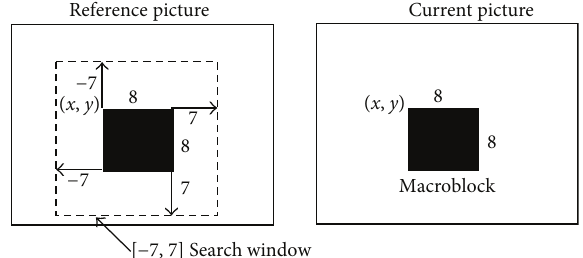
Figure 1: The reference picture with search window.